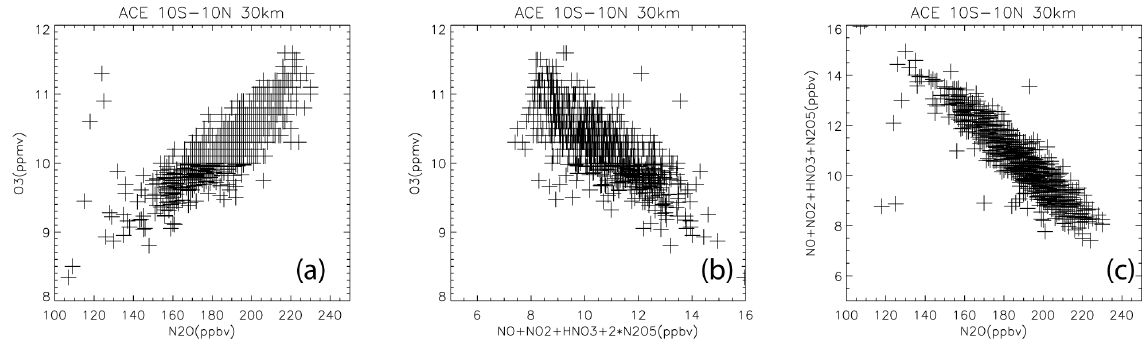
Figure 6. ACE measurements of O 3 , N 2 O, and the key members of the NO y family, NO + NO 2 + HNO 3 + 2 × N 2 O 5 . Measurements are shown for 10 ◦ S–10 ◦ N at 30km. Both sunrise and sunset measurements are included.